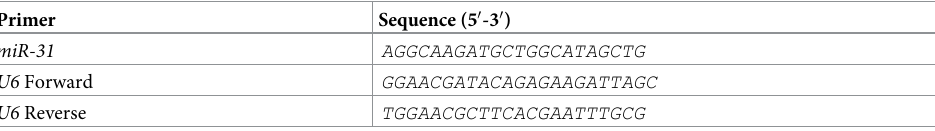
Table 1. Primer sequence of q